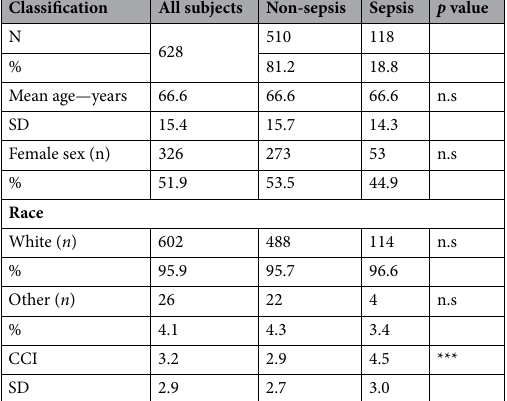
Table 1. Patient characteristics. Age, sex, and race were not significantly different between sepsis-negative and sepis-positive groups. CCI was significantly different between sepsis negative and sepsis positive groups. SD standard deviation, CCI Charlson Commobidity Index. *** p <